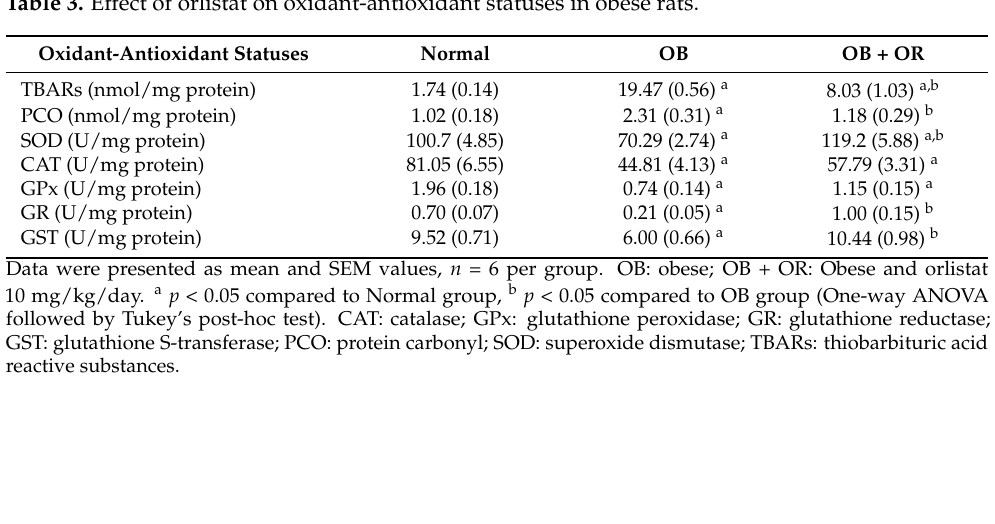
Table 3. Effect of orlistat on oxidant-antioxidant statuses in obese